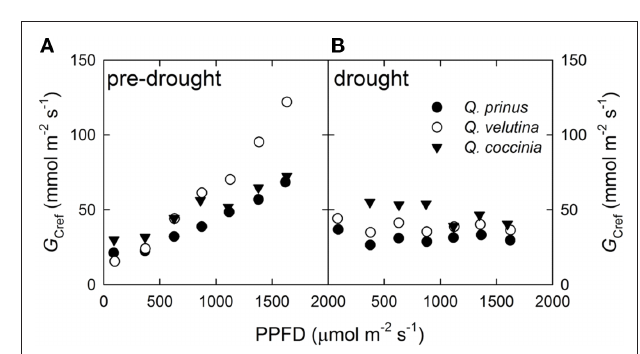
Figure 2 | reference canopy stomatal conductance ( G to light (PPFD) (A) pre-drought and (B) during drought. Quercus prinus (filled circle), Q. velutina (open circle), and Q coccinea (filled triangle).